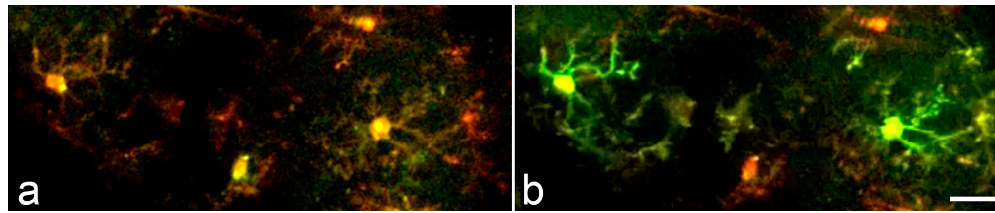
Figure 4. Synchronous microglial Ca 2+ activity in the mouse cortex. ( a , b ) Time lapse two-photon images acquired within a 20-second interval from a LPS- and bicuculline-treated animal demonstrate synchronized microglial Ca 2+ transients. Scale bar: 20 µm. Modified from [16].